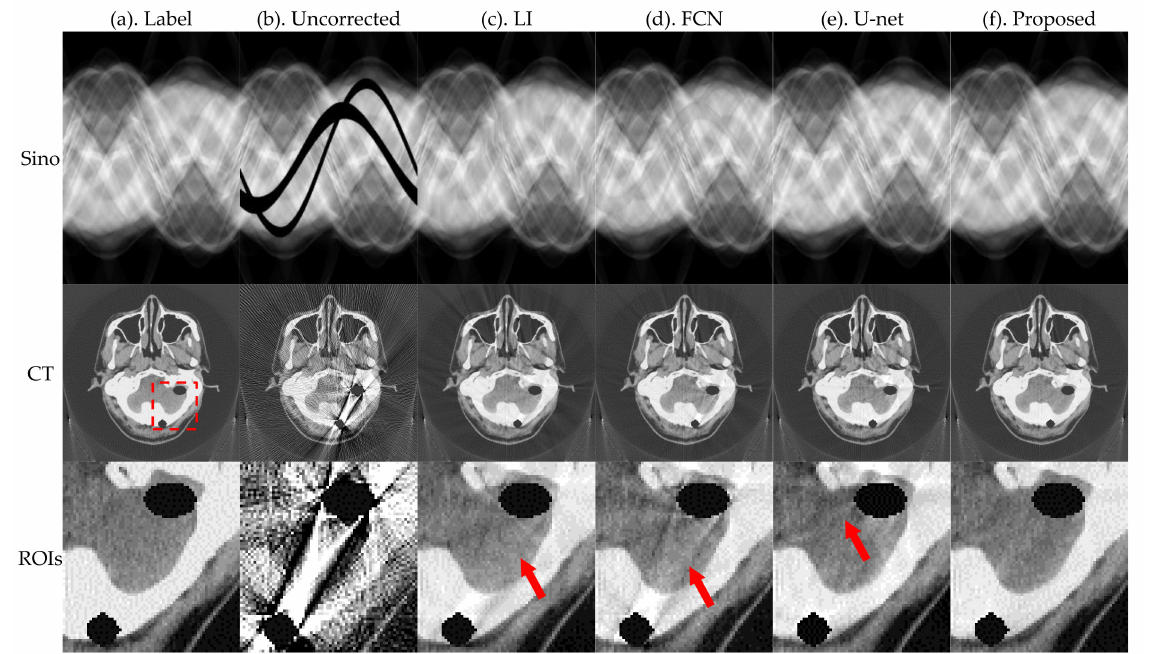
Figure 6. Simulation results of the cranial, where the first row is the sinogram, and the second row is the FBP-reconstructed results. The display window of sinogram is (0, 1). The display window of CT is ( − 0.1, 0.25).